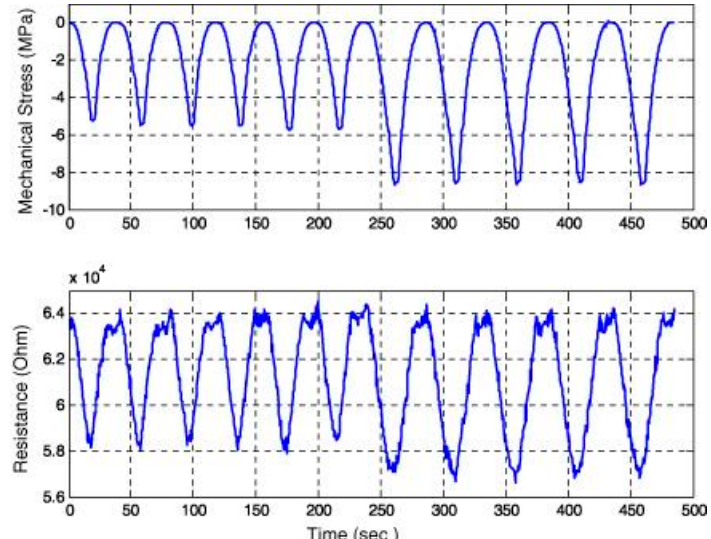
Figure26. Thepiezoresistivitybehaviourofcementpasteenhancedwith0.1%ofcarboxylfunctionalized Figure 26. The piezo resistivity behaviour of cement paste enhanced with 0.1% of carboxyl MWCNTs. Reproduced with permission from [179], IOP Sciences, functionalized MWCNTs. Reproduced with permission from [179], IOP Sciences, 2009.